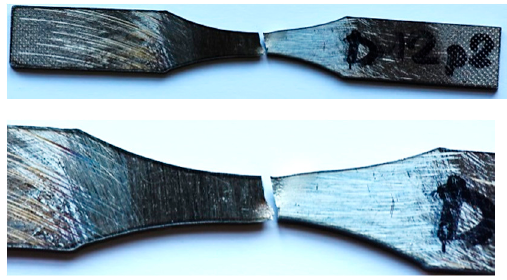
Figure 10. The hourglass specimen made of the Docol 1200 M steel with the micro-jet cooling weld after fatigue test at maximum value of stress of 500 MPa.